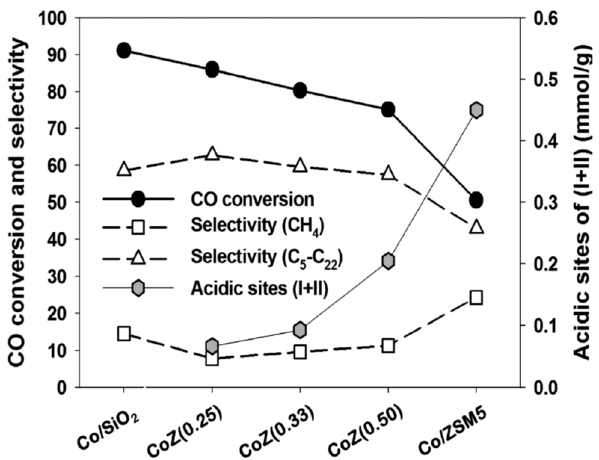
Figure 26. Catalytic performance (CO conversion and product distribution) with respect to the acid site density on the ZSM-5-modified Co/SiO 2 catalysts. Reprinted with permission from [117]. Copyright (2012) ACS, Washington, DC, America.